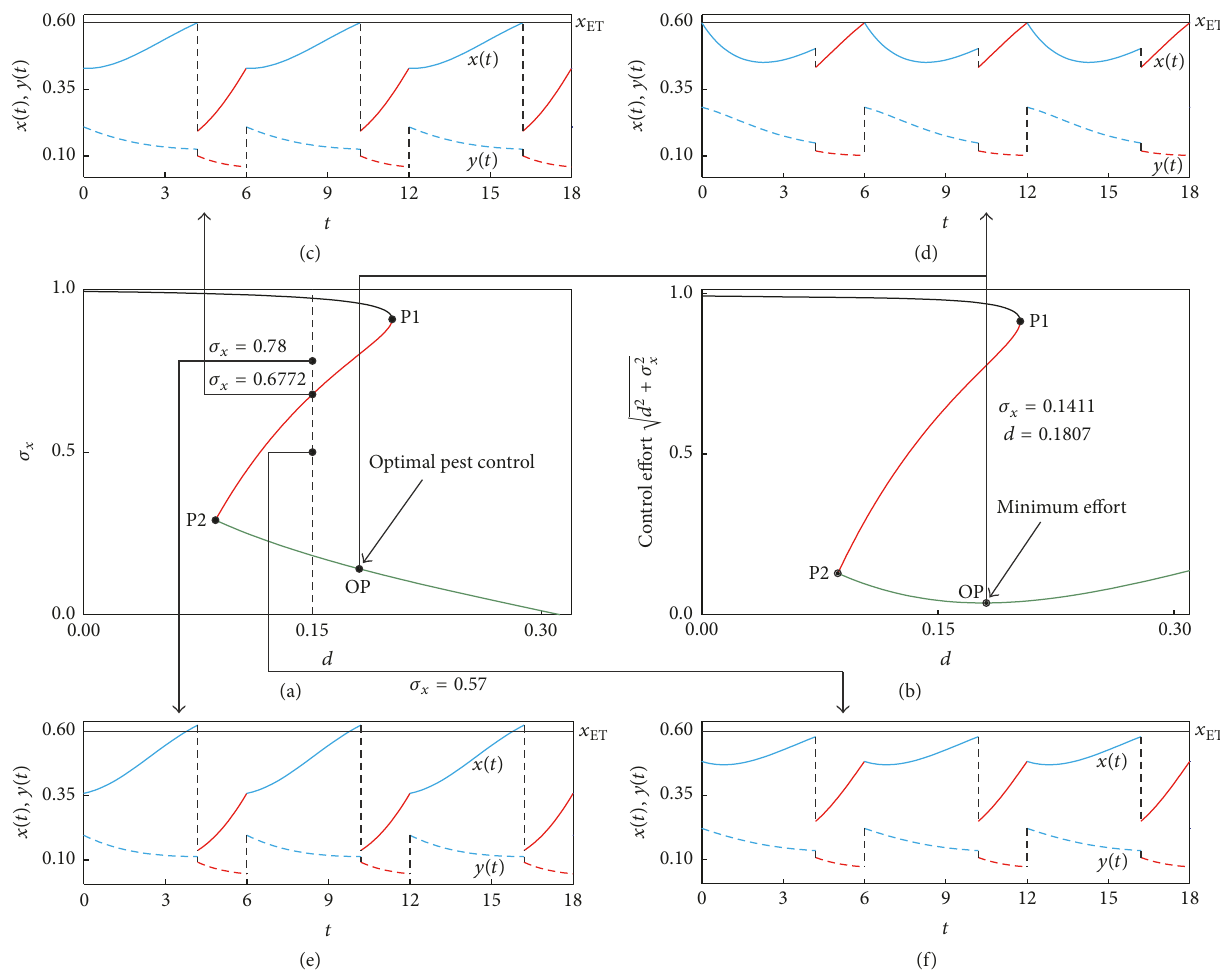
Figure 4: Numerical continuation of the periodic response of system (14) with respect to 𝑑 and 𝜎 𝑥 , computed for impulse period 𝑇 = 6 . (a) Along this curve, the auxiliary boundary condition (13) is used to keep 𝑀 𝑃 = 𝑥 ET = 0.6 constant (economic threshold). (b) depicts the same result, but in this case the control effort, computed as the modulus of the vector (𝑑,𝜎 𝑥 ) , is monitored. In this picture, the optimal operation point is defined as the parameter values for which the control effort is minimum. (c)–(f) present solutions of the system for different combinations of 𝑑 and 𝜎 𝑥 .